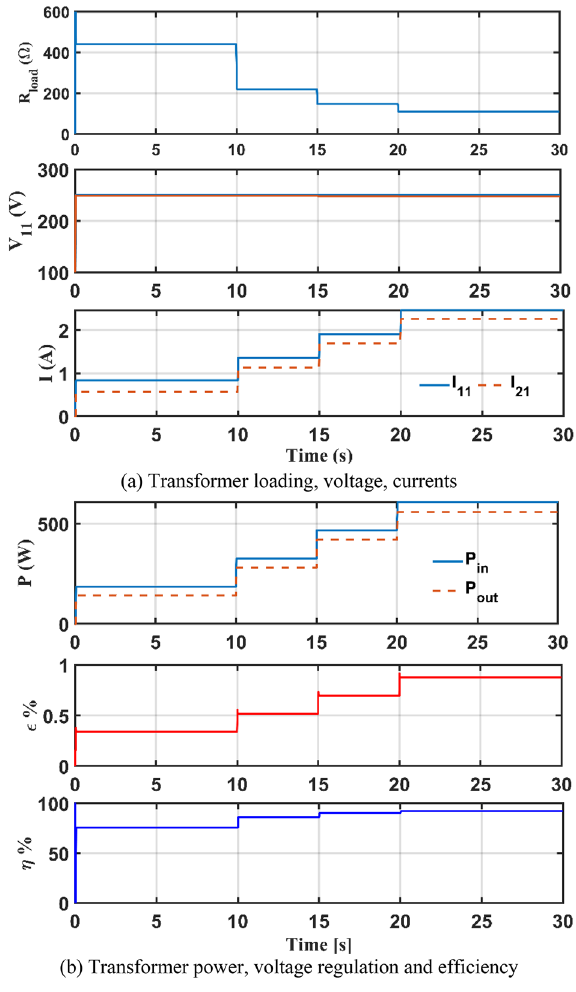
Figure 8. Transformer performance at varied load and UPF as produced by